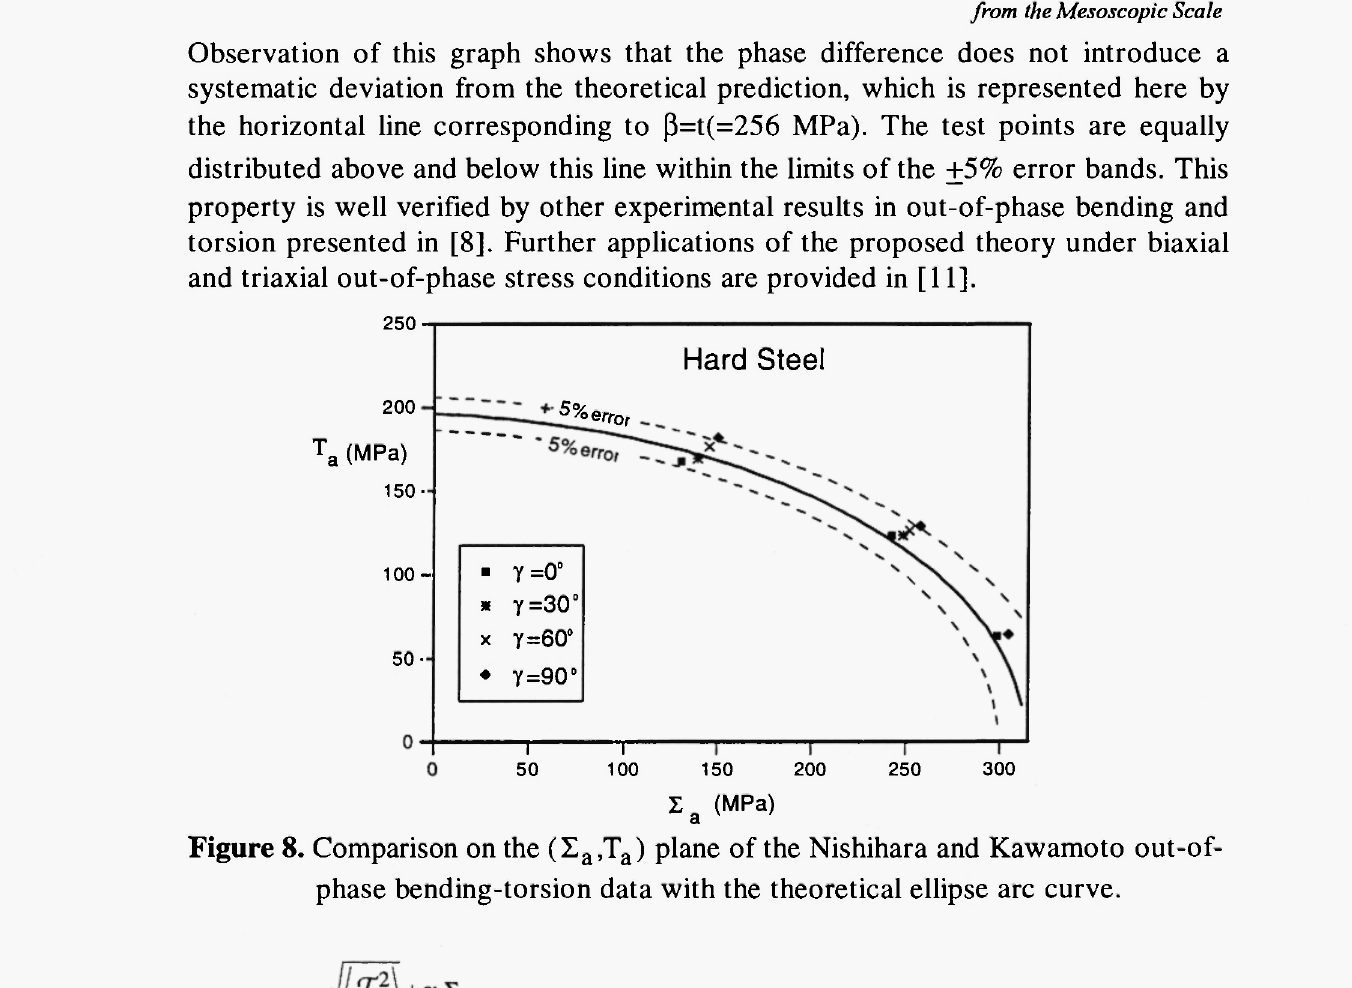
Figure 8. Comparison on the (E ,T ) plane of the Nishihara and Kawamoto out-of- a a phase bending-torsion data with the theoretical ellipse arc curve.